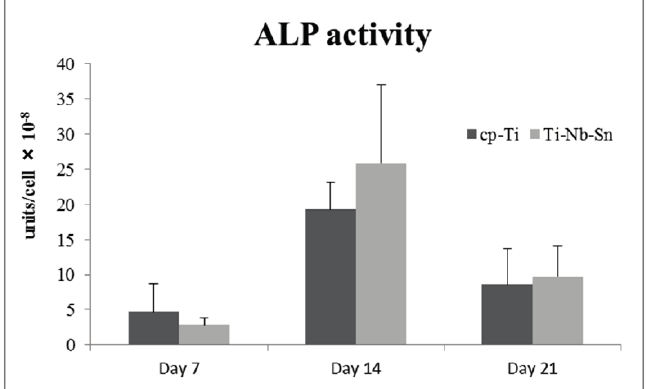
Figure 4. ALP activity. Data are the mean ± SD ( n = 5).